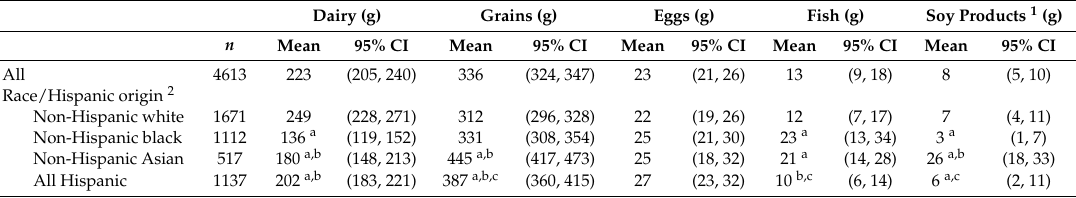
Table 3. Mean consumption of dairy, grains, eggs, fish, and soy products among children and adults aged 6 years and over, NHANES